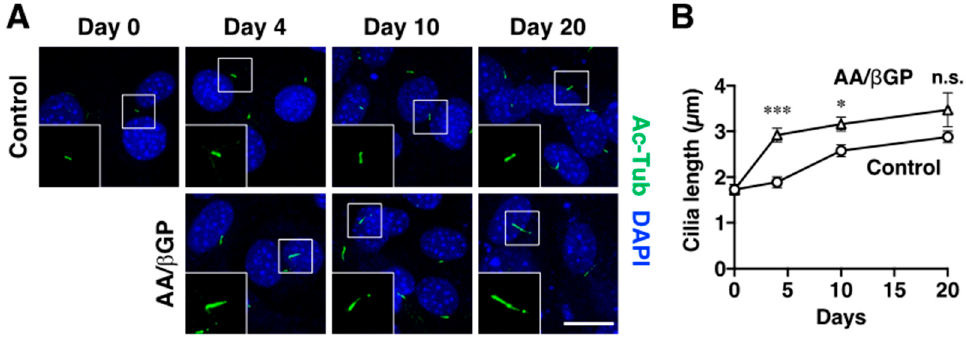
Figure 3. Primary cilia are elongated in the differentiating MC3T3-E1 cells. Confluent MC3T3-E1 cells were treated in the presence or absence of AA/ β GP for 4, 10, and 20 days. ( A ) The cells were immunolabeled with an anti-acetylated α -tubulin (Ac-Tub) antibody. The cell nuclei were labeled by 4 ′ ,6-diamidino-2-phenylindole dihydrochloride (DAPI). The boxed areas indicate the enlarged regions. ( B ) Quantification of the cilia length. Data are presented as the mean ± S.E.M. from 29–87 cilia. * p < 0.05, *** p < 0.001, two-way ANOVA followed by Bonferroni’s test (vs Control of each day). n.s., not significant. Scale bar, 20 µm.